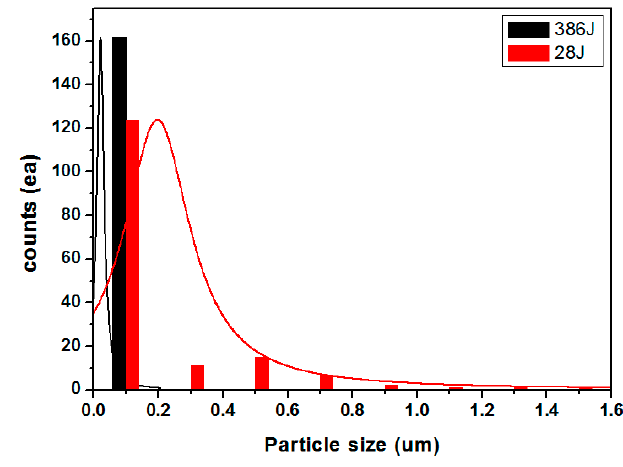
Figure 12. Histogram of a carbide in 386J and 28J specimens.